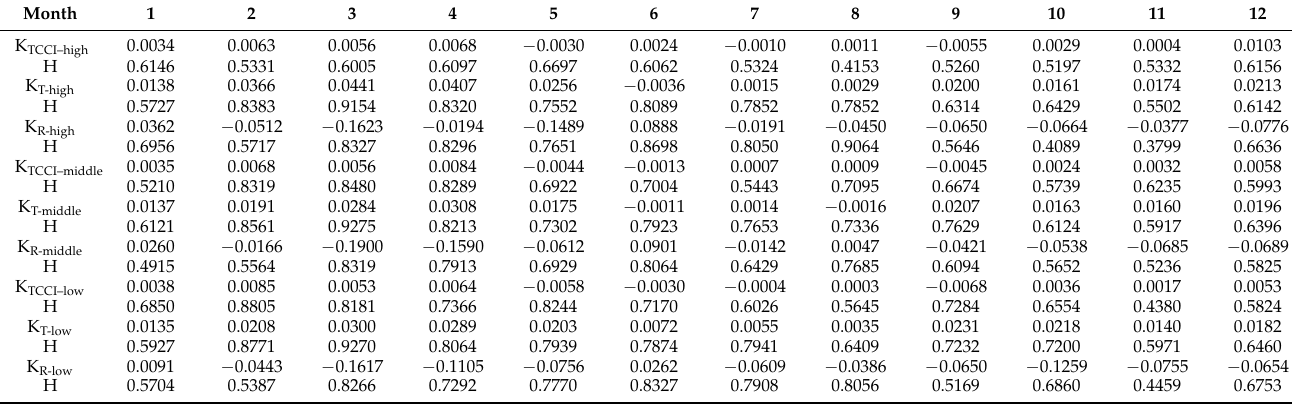
Table 3. Development trend of the monthly variation of different grades of the TCCI in Henan Province in the